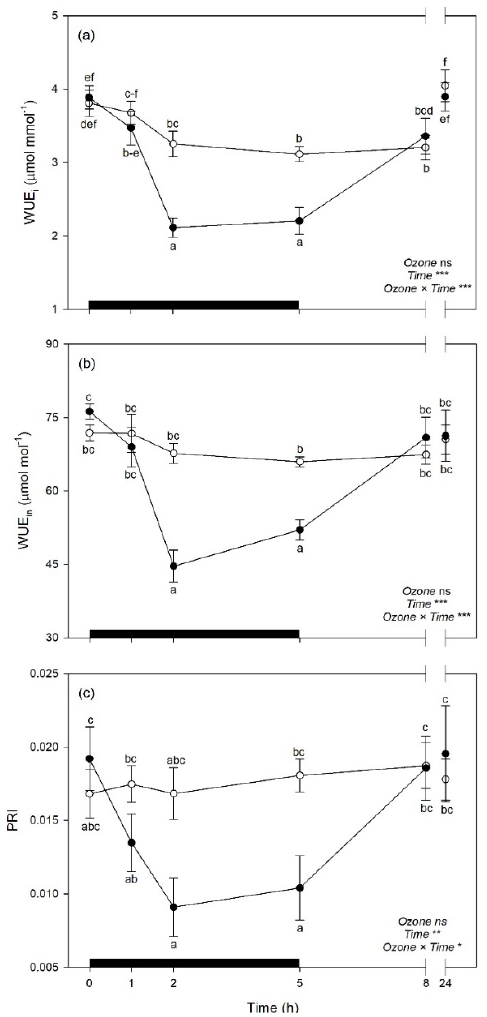
Figure 7. Time course of ( a ) instantaneous water use efficiency (WUE i ), ( b ) intrinsic water use efficiency (WUE in ), and ( c ) photochemical reflectance index (PRI) in sage plants exposed to charcoal-filtered air (open circle) or to 200 ppb of ozone for 5 h (closed circle). Data are shown as mean ± standard error. Measurements were carried out at 0, 1, 2, 5, 8, and 24 h from the beginning of exposure. p -Values for the effects of ozone (between factor), time (within factor), and their interaction from a one-way repeated measures ANOVA are shown (*** p ≤ 0.001; ** p ≤ 0.01; * p ≤ 0.05; ns: p > 0.05). According to Tukey’s post-hoc test, different letters indicate significant differences among means ( p ≤ 0.05). The thick black bar indicates the time of ozone exposure (i.e., 5 h).